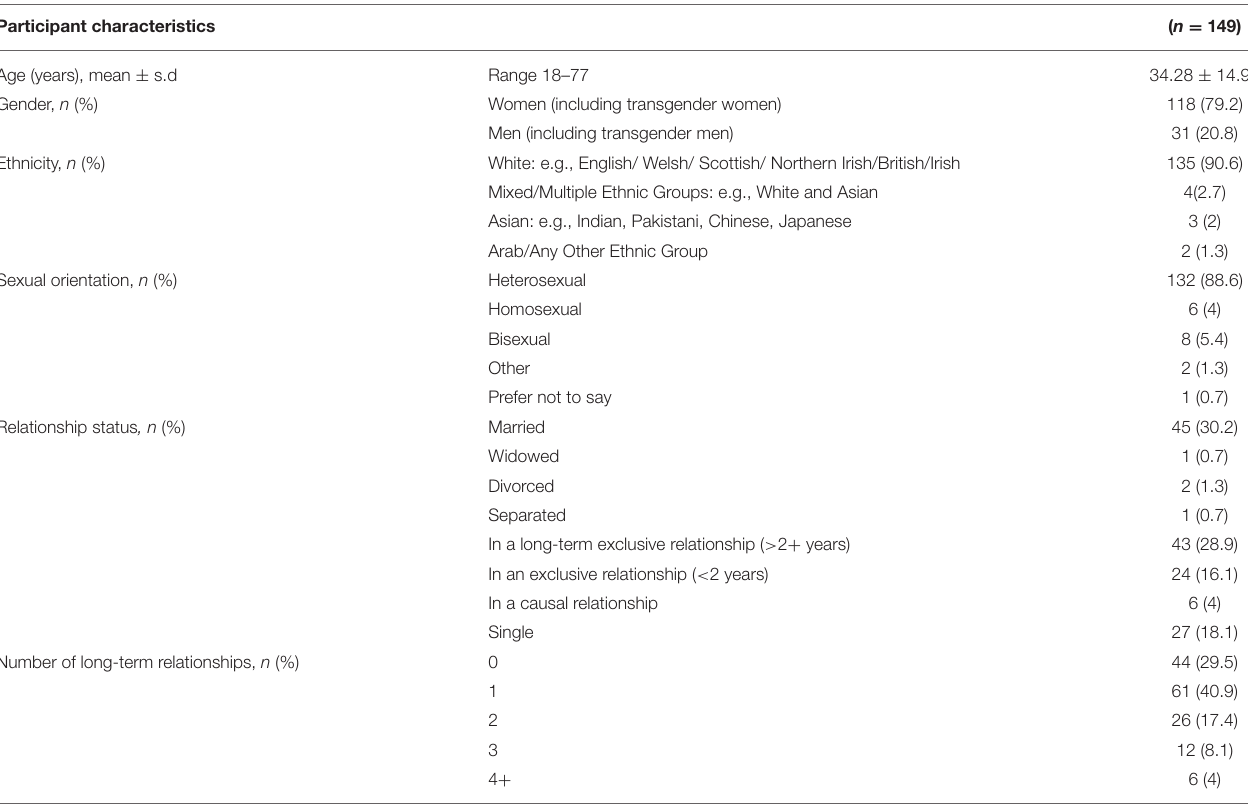
TABLE 1 | Demographic characteristics of the participants. Participant